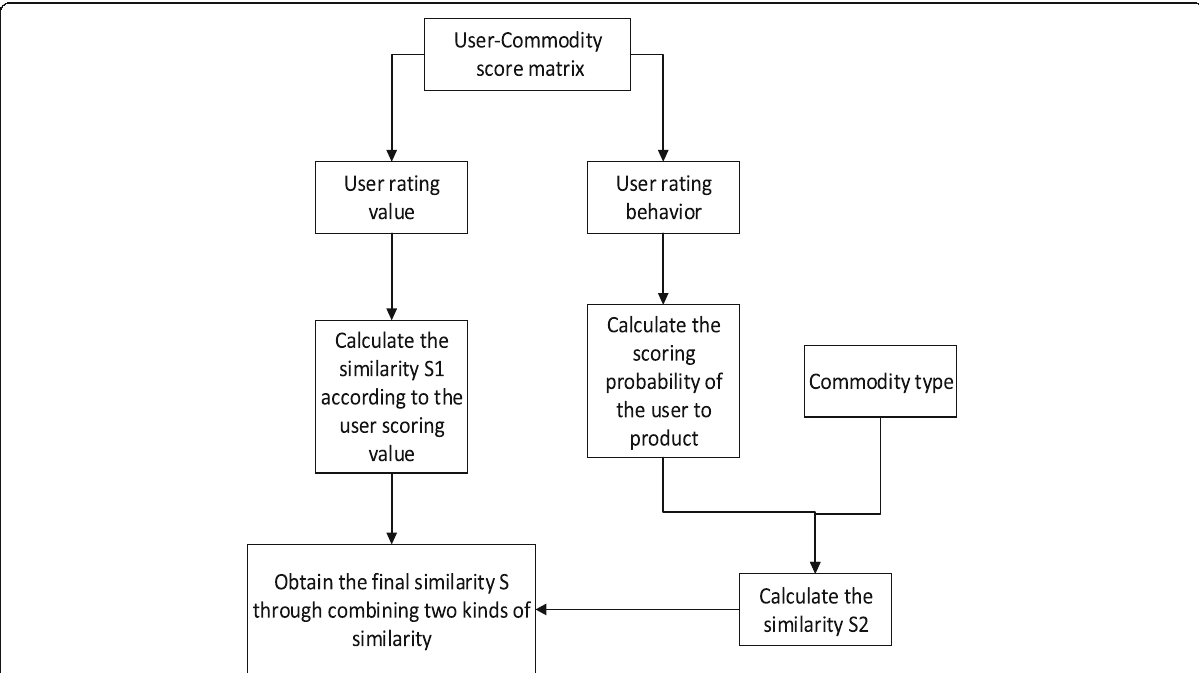
Fig. 2 Similarity calculation of an improved algorithm model. The behavior that a user gives a score to a commodity is called the user rating behavior. The score value that the user gives to the commodity is called the user rating value. The frame calculates the score probability P based on the user rating behavior and calculates the similarity S2 according to the score probability P and the project type. Then, we calculate the similarity S1 according to the user rating value. Finally, we combine the two similarity values S1 and S2 to obtain the ultimate similarity